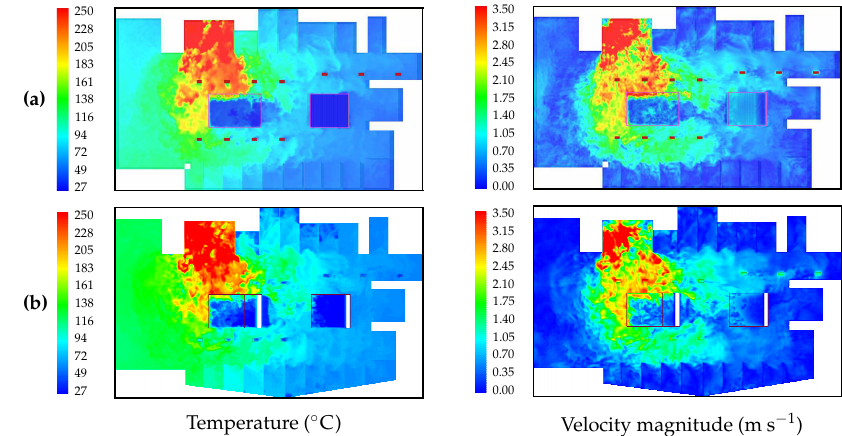
Figure 16. Temperature contours (left column) and velocity magnitude contours (right column) at t = 240 s, obtained as in Figure 13. (a) FDS; (b) FLUENT.